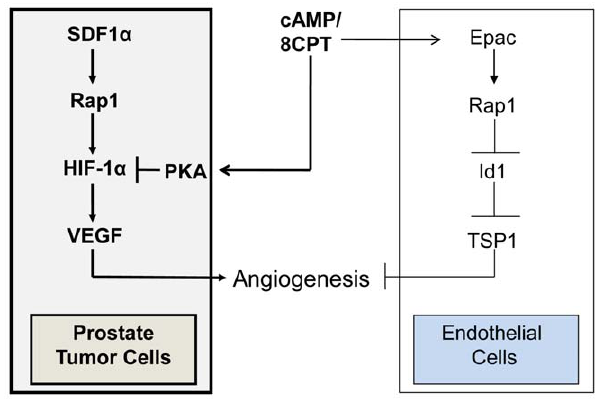
Figure 7. Schematic depicting interplay between Rap1 and PKA in the tumor microenvironment.